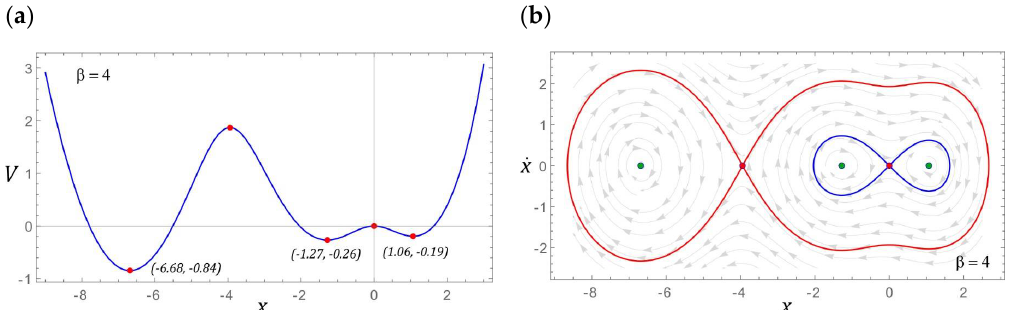
Figure 14. The localization of fixed points is shown as ( a ) potential characteristics, ( b ) phase plane with the corresponding homoclinic orbits and vector fields.